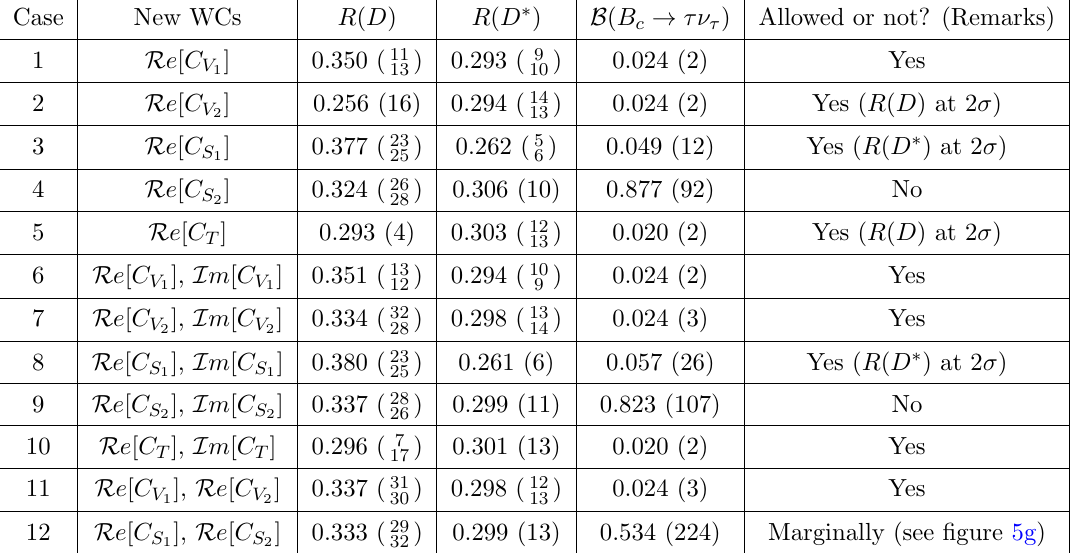
Table 8. R ( D ( (cid:3) ) ) predictions for the di(cid:11)erent new physics scenarios using the (cid:12)t to all experimental inputs in table 7. The cases with B ( B c ! (cid:28)(cid:23) (cid:28) ) > 30% are physically ruled out.